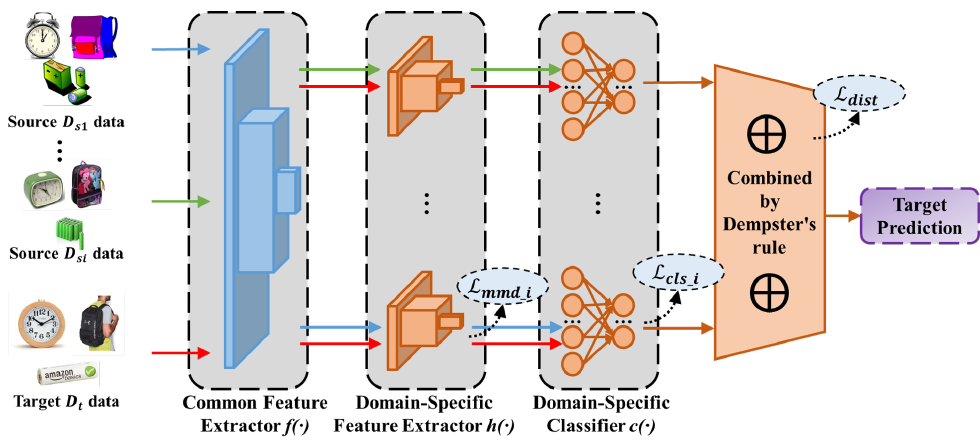
Figure 2. The overall structure of